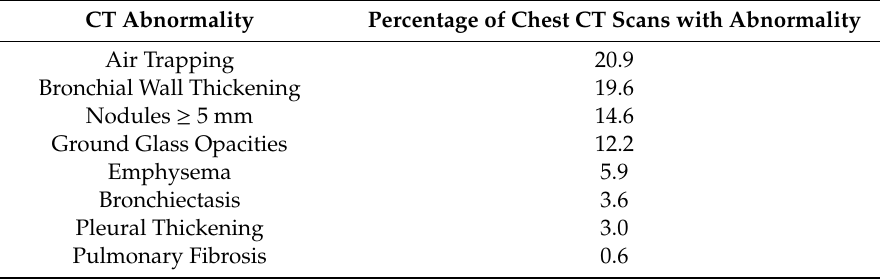
Table 2. Prevalence of CT